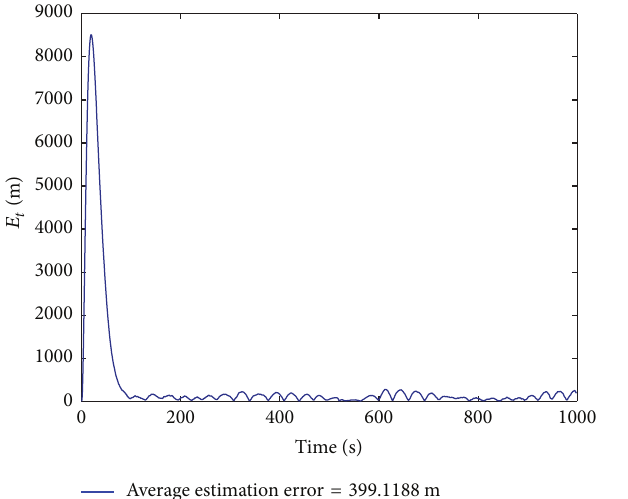
Figure 18: Azimuth beam steering angle of ship-borne phased array radar.